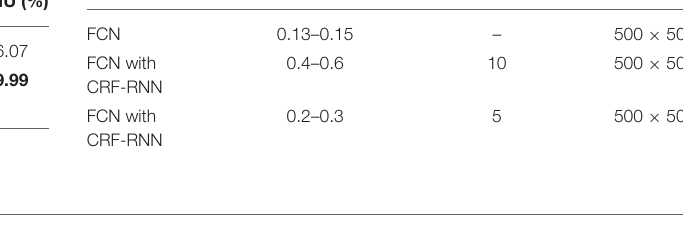
TABLE 4 | Comparison of the class-wise accuracy on the MINC dataset.